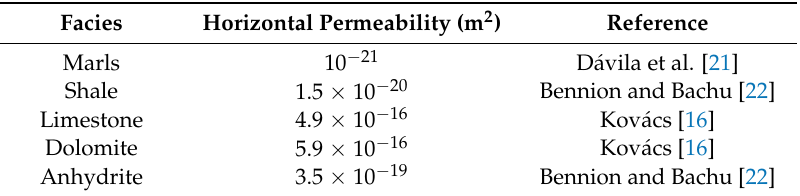
Table 2. Permeability of the matrix